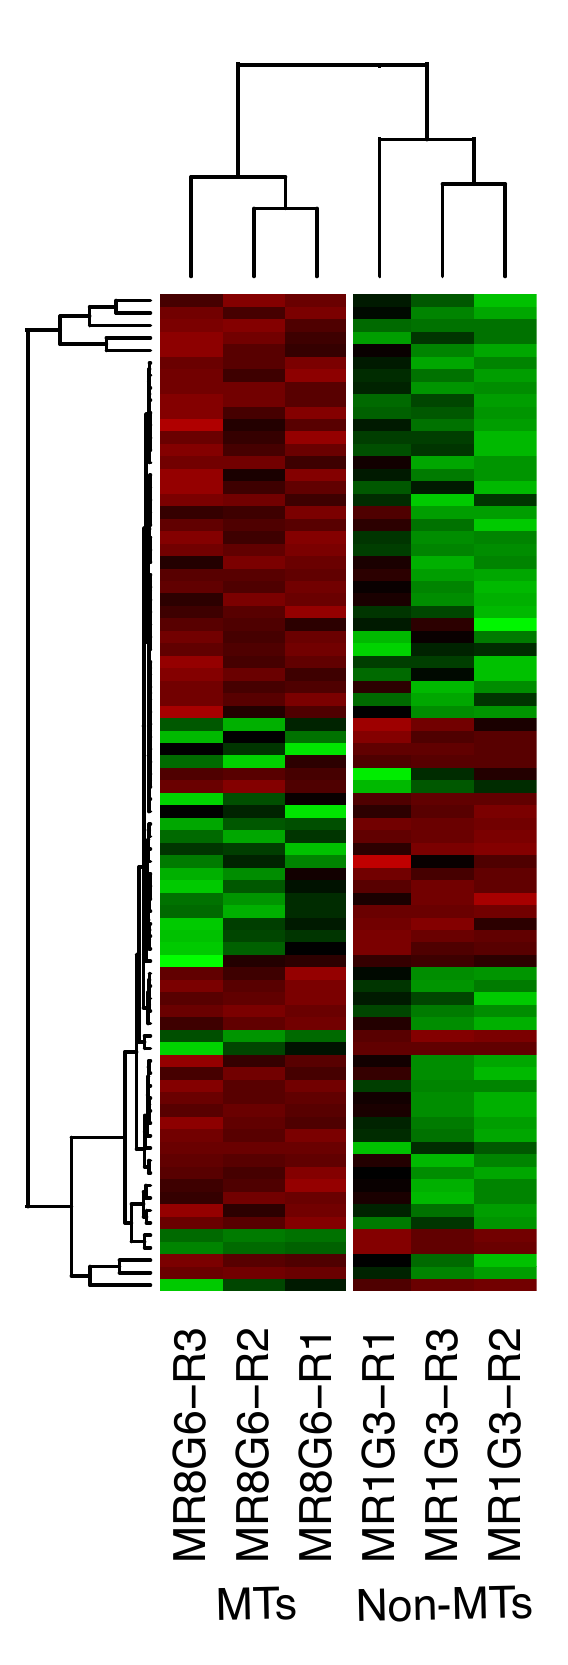
Figure 4. Hierarchical clustering analyses (HCA) and heat map of up- and down-regulated TFs during MTs development under darks conditions, levels of up-regulation are present in